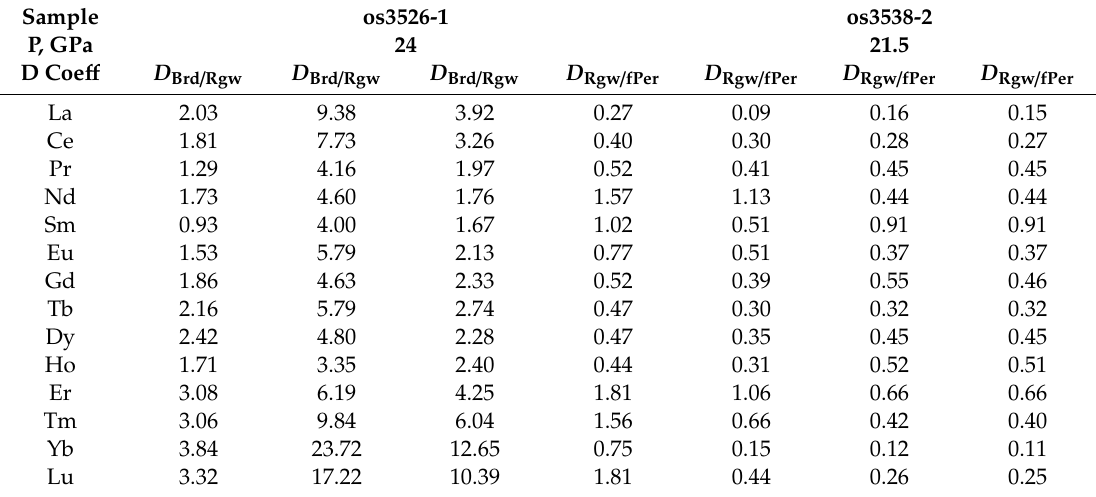
Table 5. Partition coefficients for synthetic phases from runs at 1600 ◦ C with mixREE starting composition. Sample os3526-1 os3538-2 P, GPa